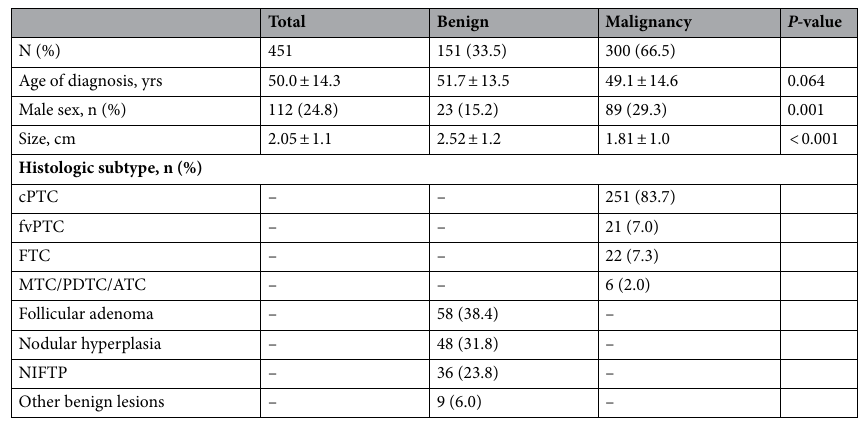
Table 1. Baseline characteristics of thyroid nodules. cPTC, conventional papillary thyroid carcinoma; fvPTC, follicular variant papillary thyroid carcinoma; FTC, follicular thyroid carcinoma; MTC, medullary thyroid carcinoma; PDTC, poorly differentiated thyroid carcinoma ; ATC, anaplastic thyroid carcinoma; NIFTP, noninvasive follicular thyroid neoplasm with papillary-like nuclear features, p- value for benign vs.